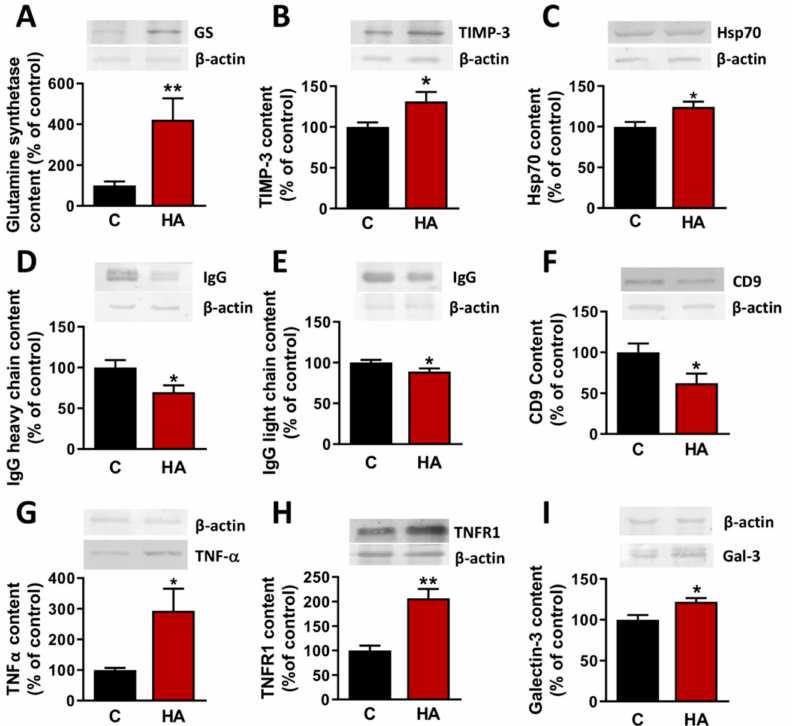
Figure 4. Extracellular vesicles protein cargo analyzed by Western blot. Content of ( A ) glutamine synthetase ( n = 8), ( B ) TIMP-3 ( n = 8), ( C ) Hsp70 ( n = 20), ( D ) IgG heavy chain ( n = 12), ( E ) IgG light chain ( n = 16), ( F ) CD9 ( n = 12), ( G ) TNF α ( n = 9), ( H ) TNFR1 ( n = 8–10), ( I ) Galectin-3 ( n = 7–13). Values are expressed as percentage of protein cargo in control rats and are the mean ± SEM. Data were analyzed by t-test, with values significantly di ff erent from control rats indicated by asterisk (* p < 0.05, ** p <